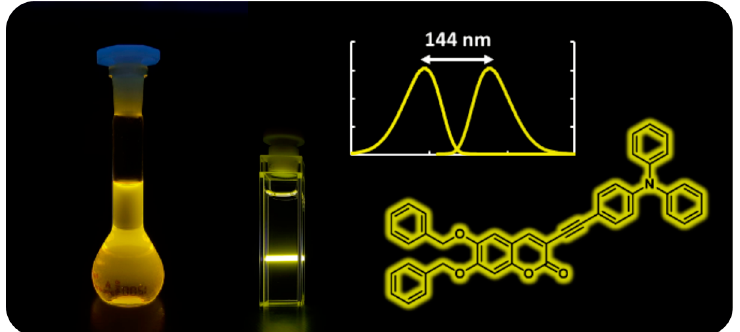
Figure 1. Structure of the coumarin–triphenylamine dye and its respective solution under UV light and with laser irradiation.